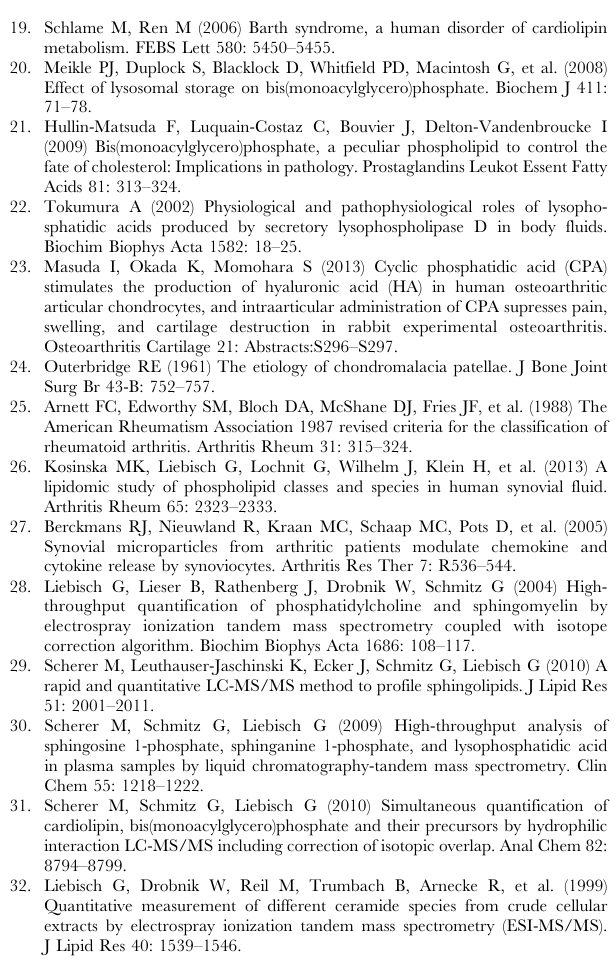
Table S1 Concentrations of lipid species presented in Figure 1–7. Lipids were determined by electrospray ionization tandem mass spectrometry or liquid chromatography coupled with tandem mass spectrometry as outlined in Material and Methods . Data (nmol/ml or pmol/ml) obtained were either uncorrected (normal font) or corrected with the dilution factor per Kraus et al. (34, bold font). Values are median and interquartile range. The